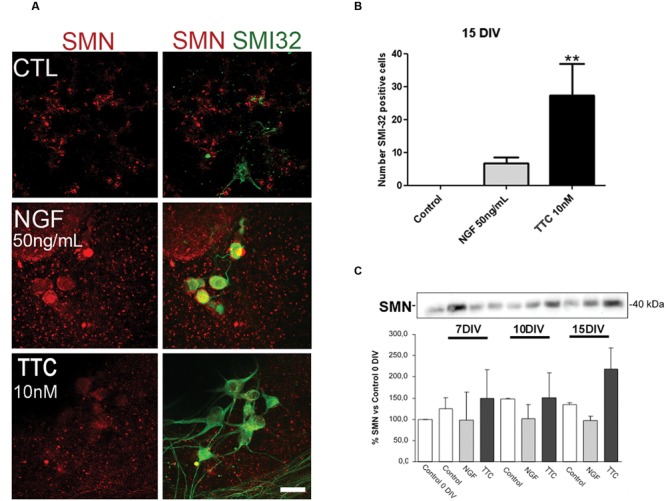
Enhanced levels of SMN protein after TTC treatment. (A) Representative images of the ventral horn hemisections immunolabeled against SMN protein (red) and motor neuron marker SMI32 (green). Scale bar: 50 μm. (B) Bar graph showing the number of SMI-32 positive cells at the ventral horns with a diameter >25 μm at 15DIV alone or under the treatment of NGF (50 ng/mL) or TTC (10 nM). Values are the mean ± SEM of at least 15 sections per treatment. ∗∗p < 0.01. (C) Evaluation by western blot analysis the levels of SMN protein under the treatment of NGF 50 ng/mL and TTC 10 nM along the progression of the spinal cord organotypic culture (0, 7, 10, and 15DIV). All results were from at least two independent experiments. Equal amount of protein was added to each well.